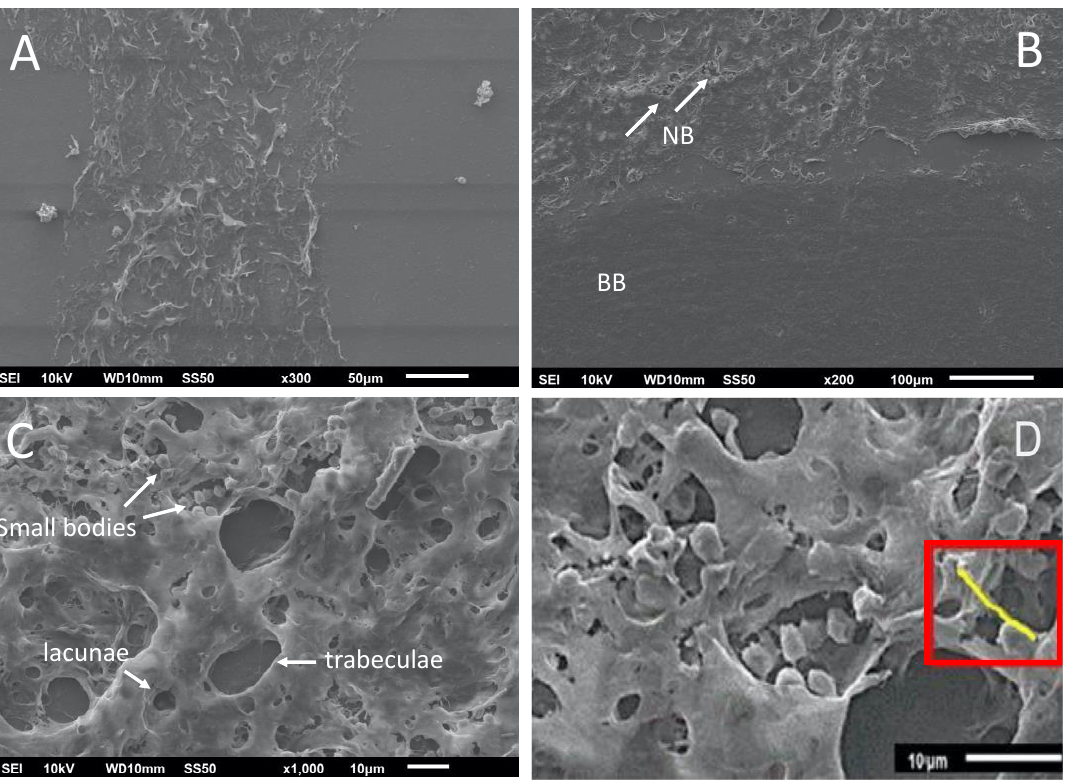
Figure 7. Scanning electron microscopy images of the calvaria at 8 weeks post-treatment. ( A ) De novo-formed bone; ( B ) de novo-formed bone showing bone trabeculae formation (white arrows) and gaps. NB, de novo-formed bone; BB, basal bone. ( C ) Small cell bodies correspond to osteoblasts and osteocytes. ( D ) Osteoid deposit after mineralization (red rectangle) . Scale bars are indicated at the bottom of each image.